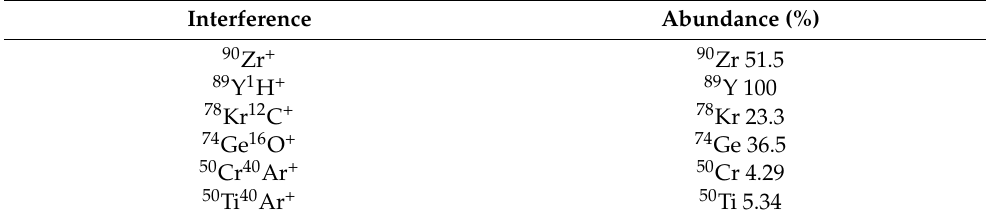
Table 2. Interferences affecting the determination of 90 Sr by mass